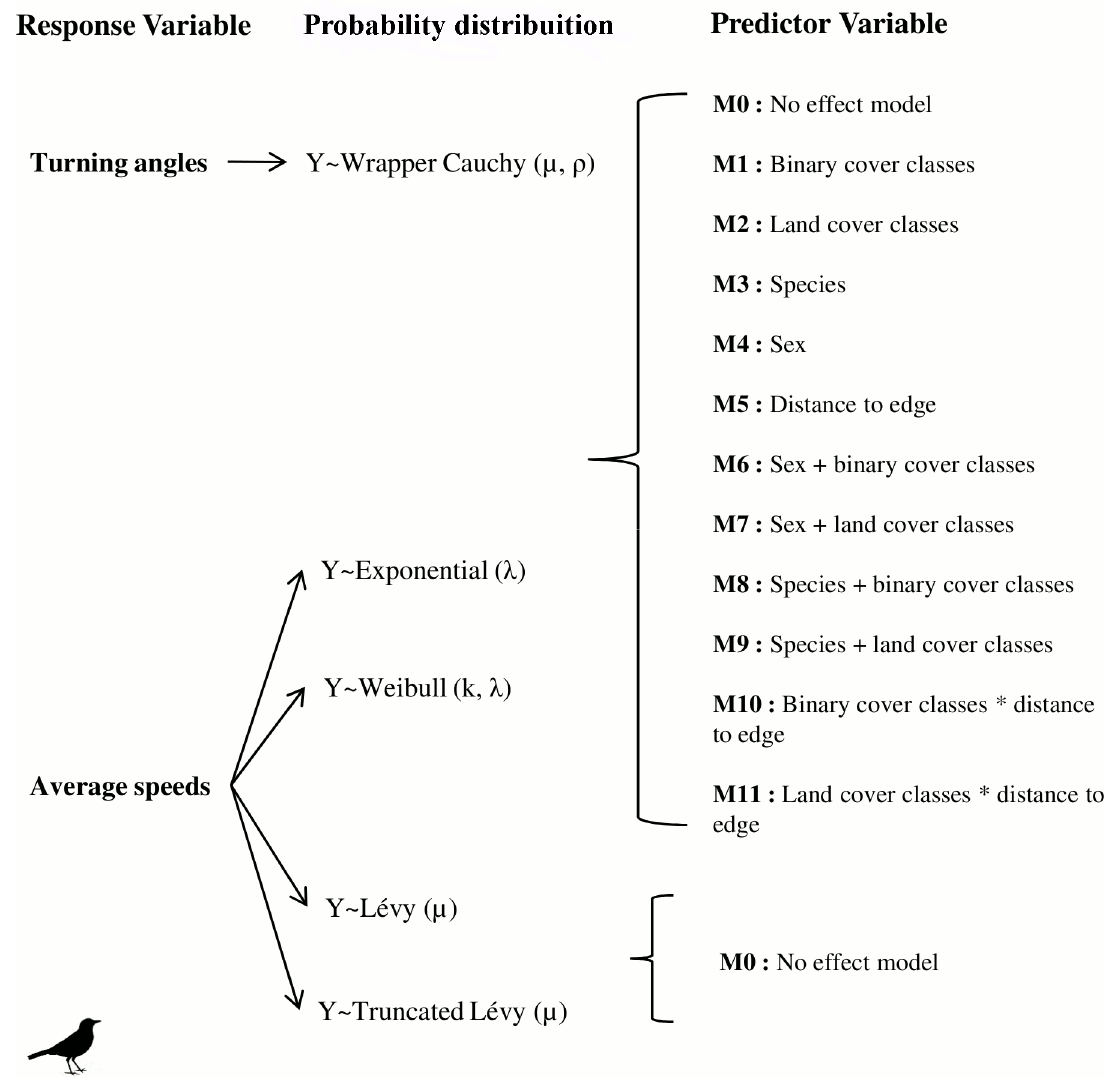
Fig 3. Set of distributions and their parameter settings used to explain variation in the response variables. Models used for the model selection approach to understand the contribution of landscape variables, sex, and species to thrush movement. Models M6-M9 considered additive effects of covariates, while models M10 and M11 consider their interaction. Y is the response